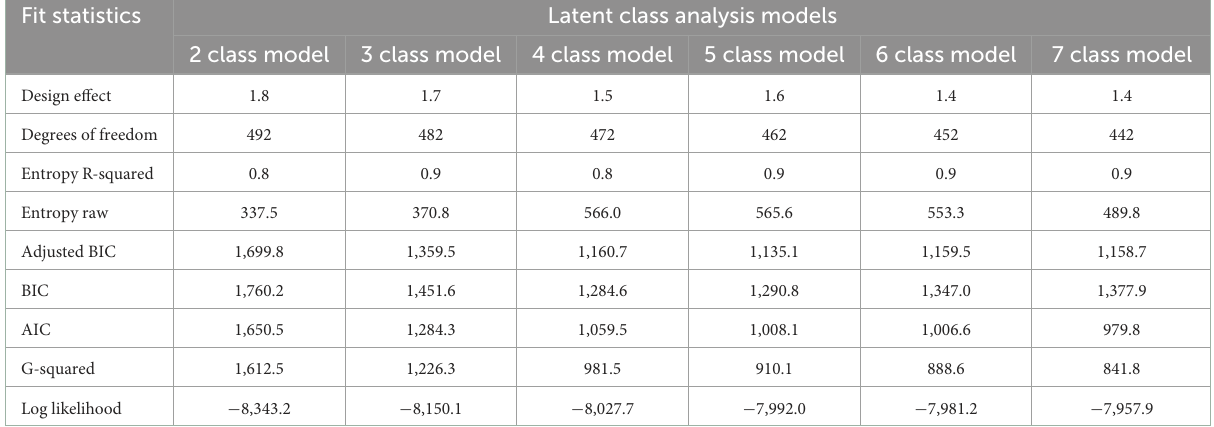
TABLE 2 Fit statistics for LCA models with different numbers of